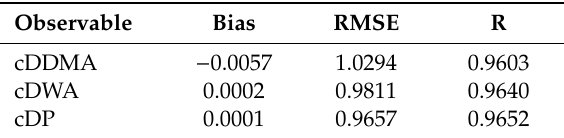
Figure 12. Scatter density plot of true wind speeds versus retrieved wind speed using ( a ) cDDMA 1 , ( b ) cDWA 1 , and ( c ) cDP 1 , respectively, extracted from the composite delay-Doppler map test data. The solid black line represents the 1:1 agreement wind speed. Table 4. Retrieved wind speed performance statistics for the di ff erent observables using the test data set. Bias and root-mean-square error (RMSE) are expressed in m / s. R represents the correlation coe ffi cient between the ground truth wind speeds and the retrieved wind